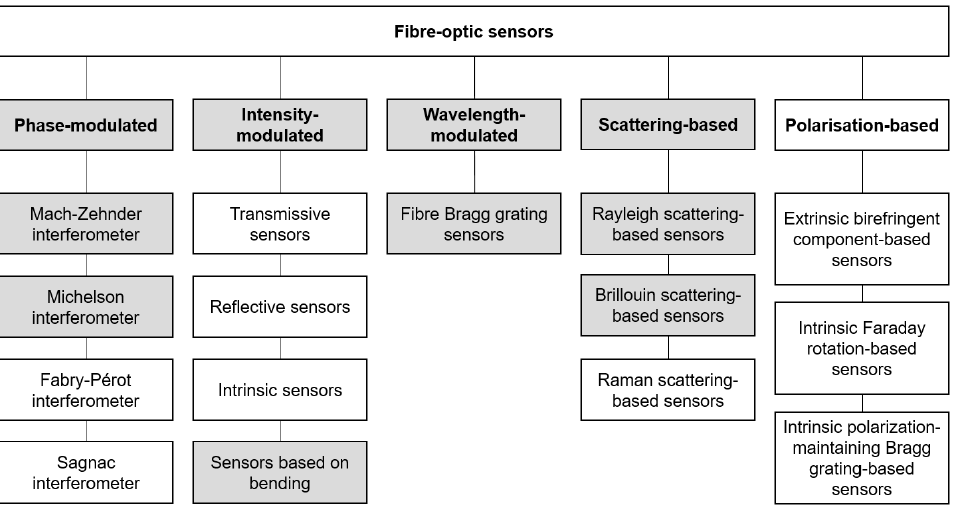
Figure 2. Five categories of fibre-optic sensors (classification adapted from [29]). Shaded in grey: FOSs mentioned in this